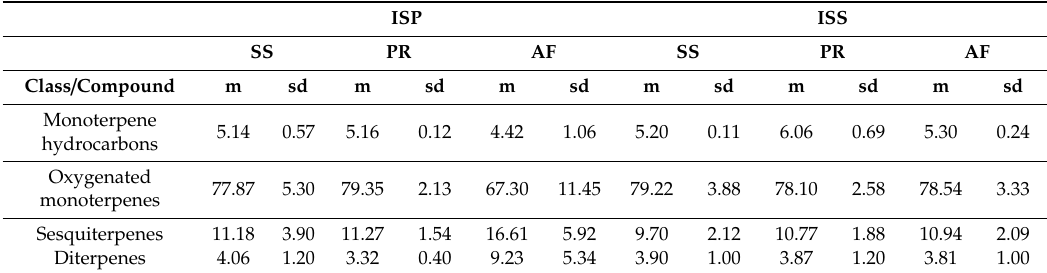
Table 11. Chemical compound main classes of clary sage essential